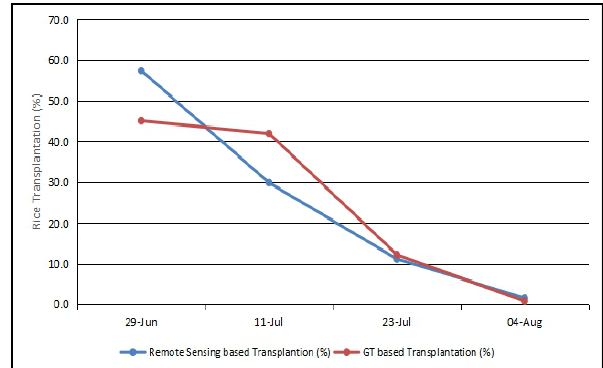
Figure 14: Rice transplantation (%) temporal pattern identified using SAR data and ground truth data in the Haryana state As shown in the graph transplantation in Haryana was completed upto first week of august. In case of West Bengal most of the rice (60%) transplanted in mid-july (Figure13). It is continued upto 3rd week of August.